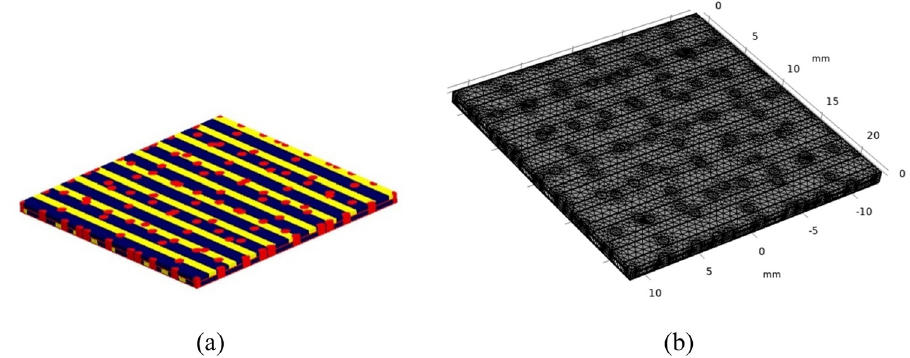
Figure 4: RVE of NP CCCs: ( a ) geometrical model and ( b ) mesh